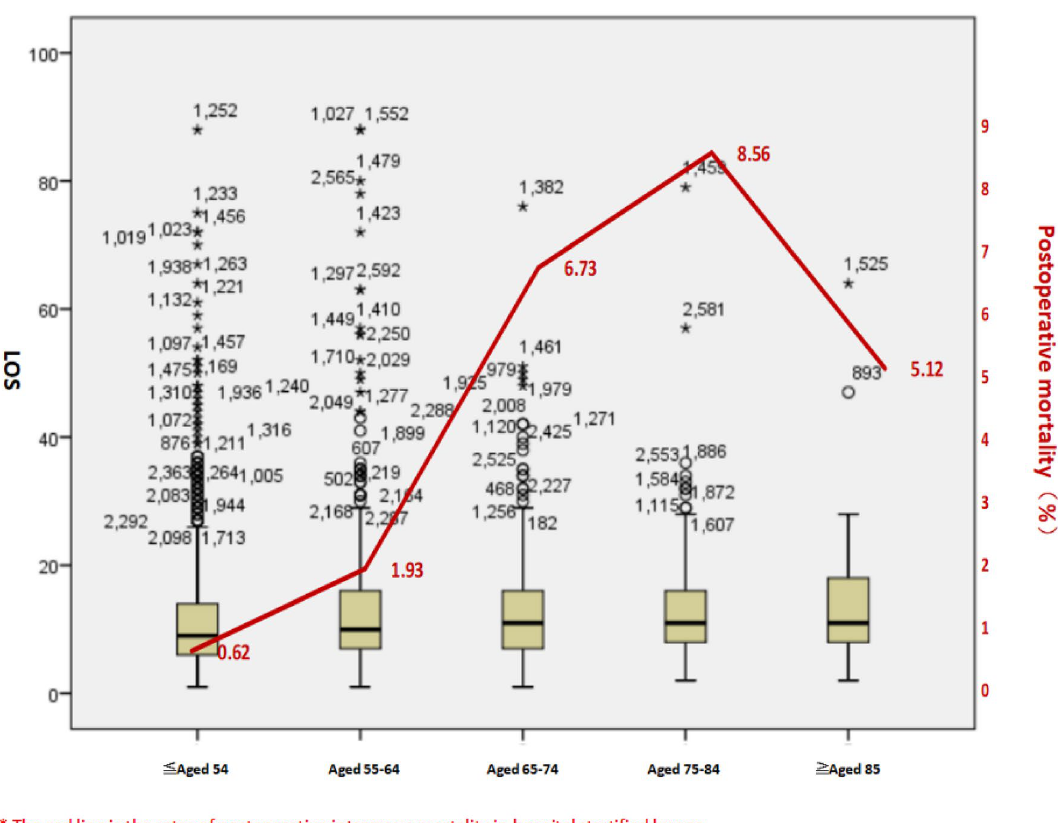
Figure 5. Stem-and-Leaf Plot :overall length of stay of patients stratified by